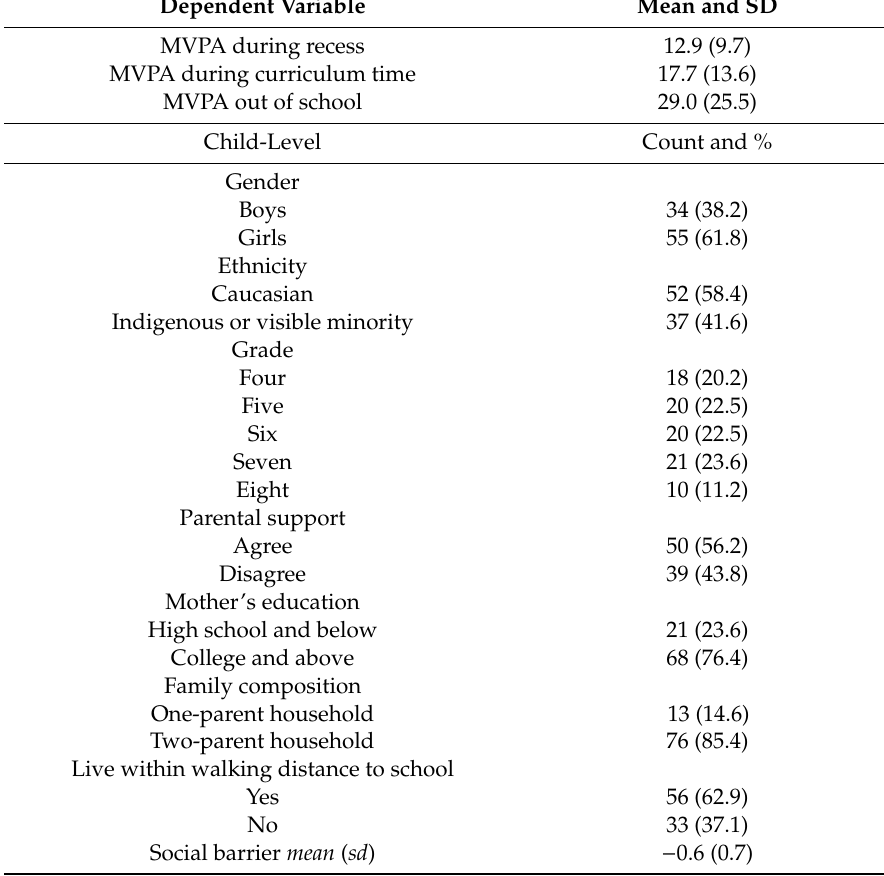
Table 1. Study characteristics for the 528 days of data from 89